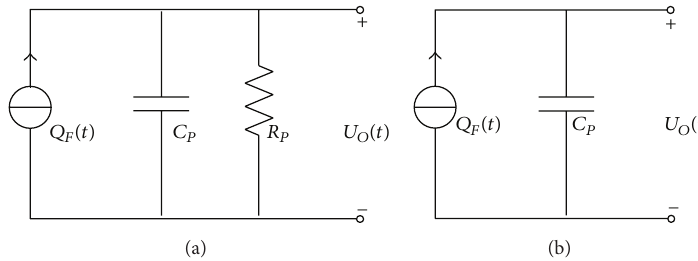
Figure 2: (a) The equivalent circuit for a PVDF energy harvester unit, (b) The ideal equivalent circuit.